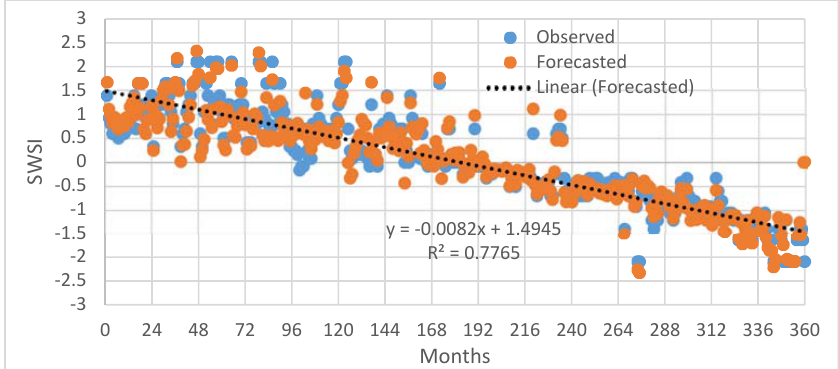
Figure 15. Scatter plot comparing observed and forecasted hydrological drought using W ‐ ANN models.